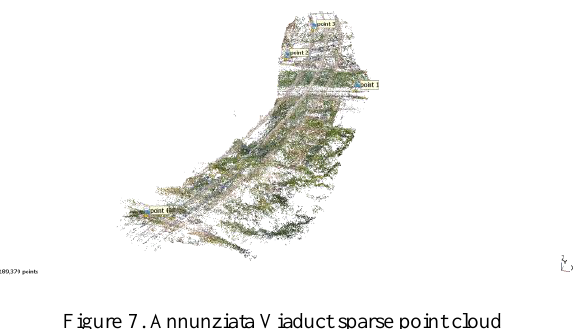
Figure 7. Annunziata Viaduct sparse point